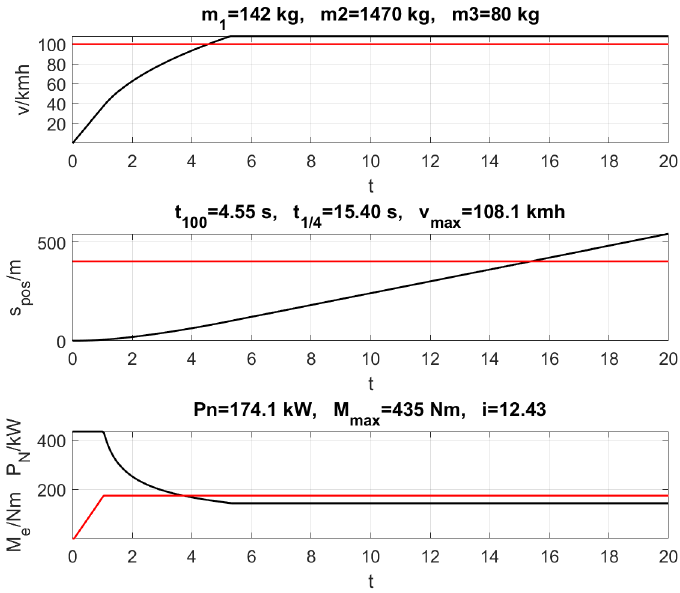
Figure 12. Optimized powertrain for 4 s acceleration to 100 kmh and motor power minimization.